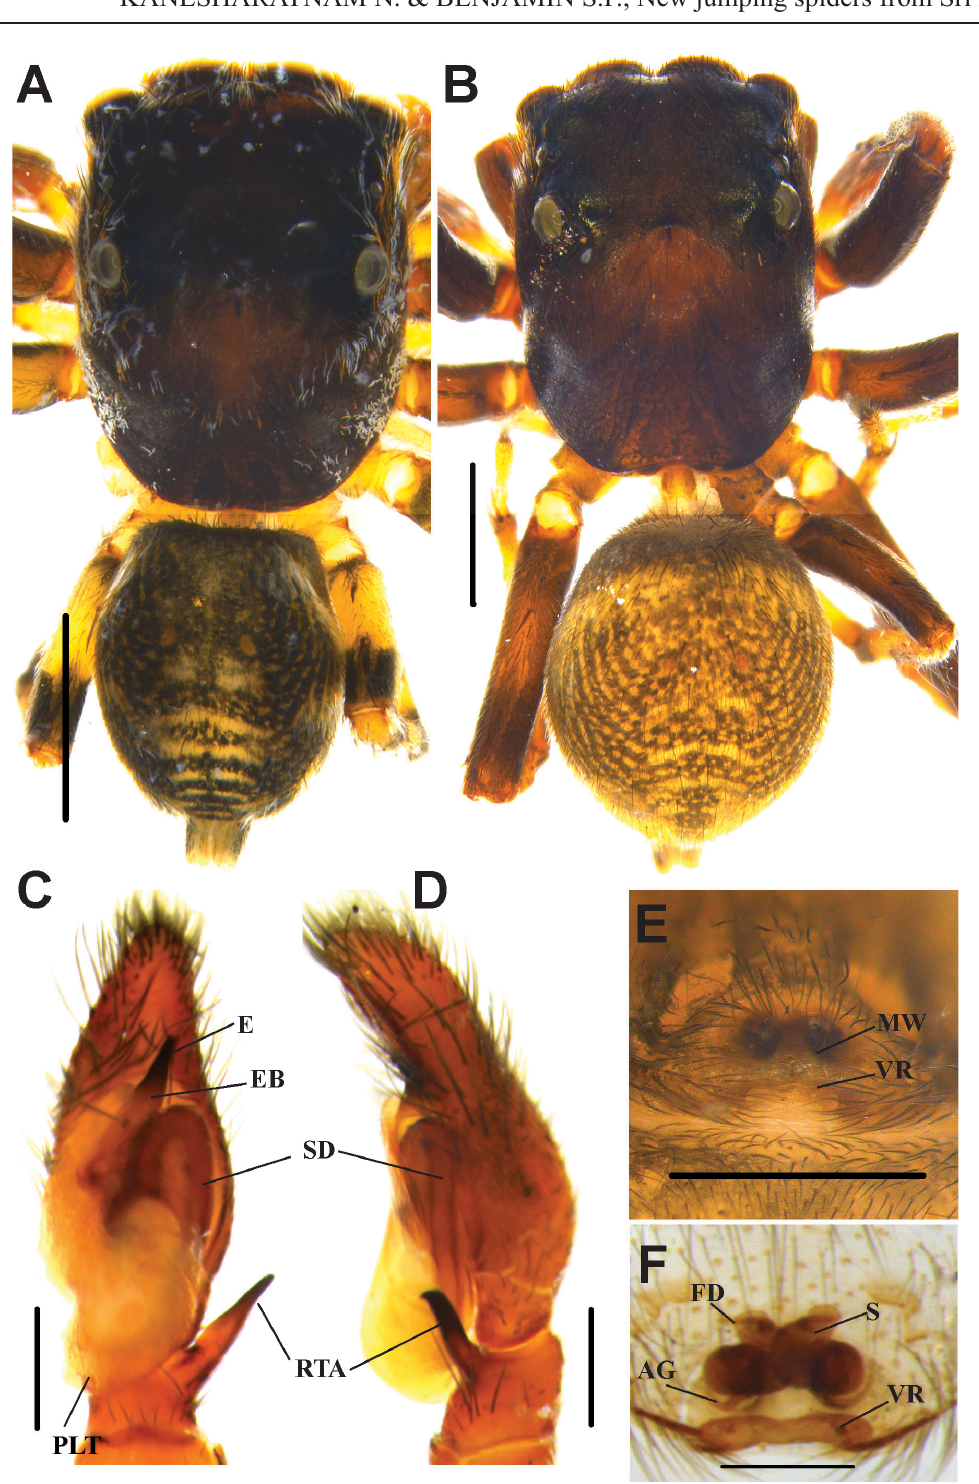
Fig. 5. Habrocestum hantaneensis sp. nov. A, C–D . ♂ (IFS_SAL 350). B, E–F . ♀ (IFS_SAL 456). A .– B . Habitus, dorsal view. C . Palp, ventral view. D . Palp, retrolateral view. E . Epigynum, ventral view. F . Vulva, ventral view. Abbreviations: AG = accessory gland; E = embolus; EB = embolic base; FD = fertilization duct; MW = membranous window; PLT = proximal lobe of tegulum; RTA = retrolateral tibial apophysis; S = spermathecae; SD = sperm duct; VR = vaginal roof. Scale bars: A–B = 1 mm; C–F = 0.2